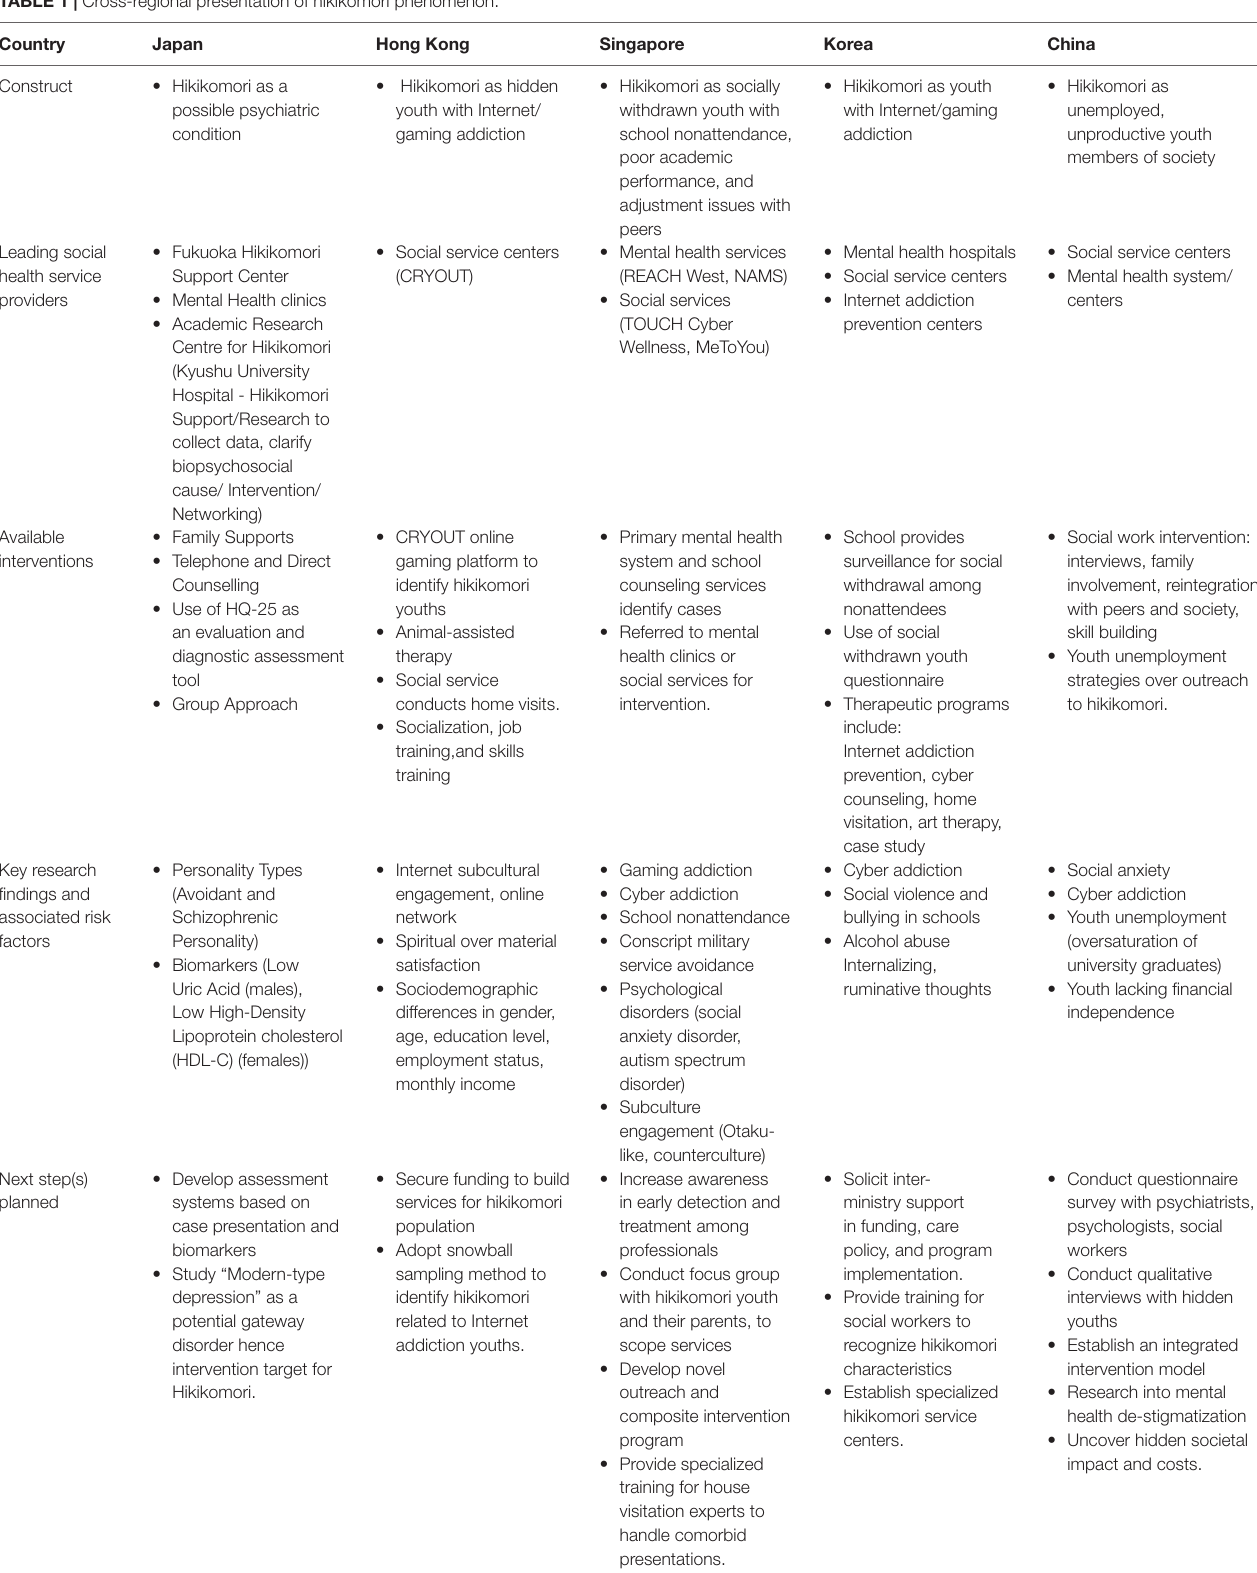
TABLE 1 | Cross-regional presentation of hikikomori